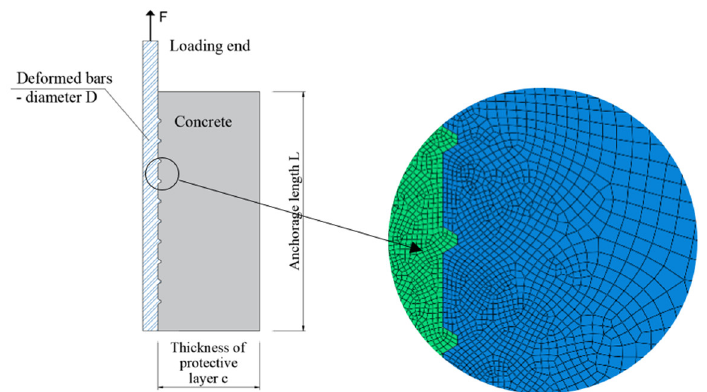
Figure 6. Mesh generation of the finite element model.